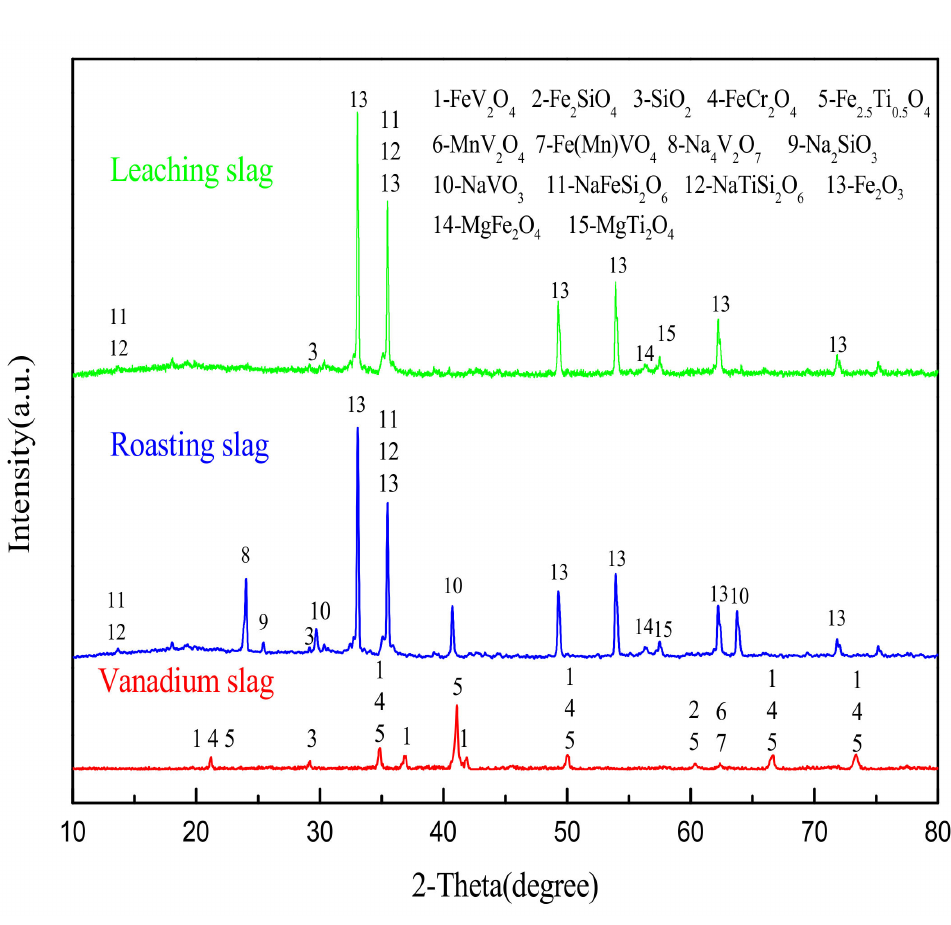
Figure 4. XRD patterns of Vanadium slag and the samples after roasting and